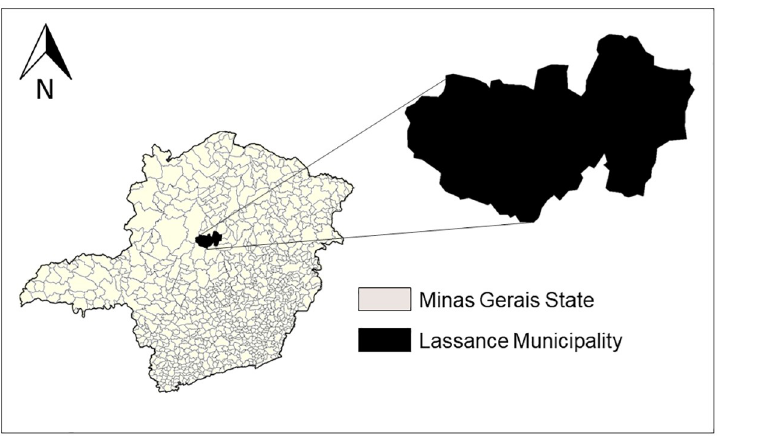
Fig 1. Location of the municipality of Lassance in the state of Minas Gerais, Brazil.